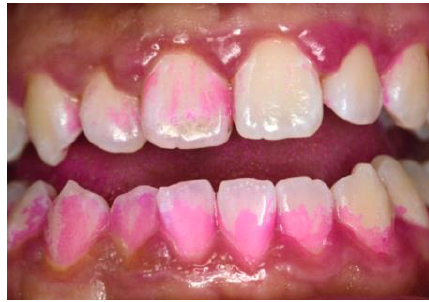
Figure 2. Intraoral frontal photographs taken for DPI